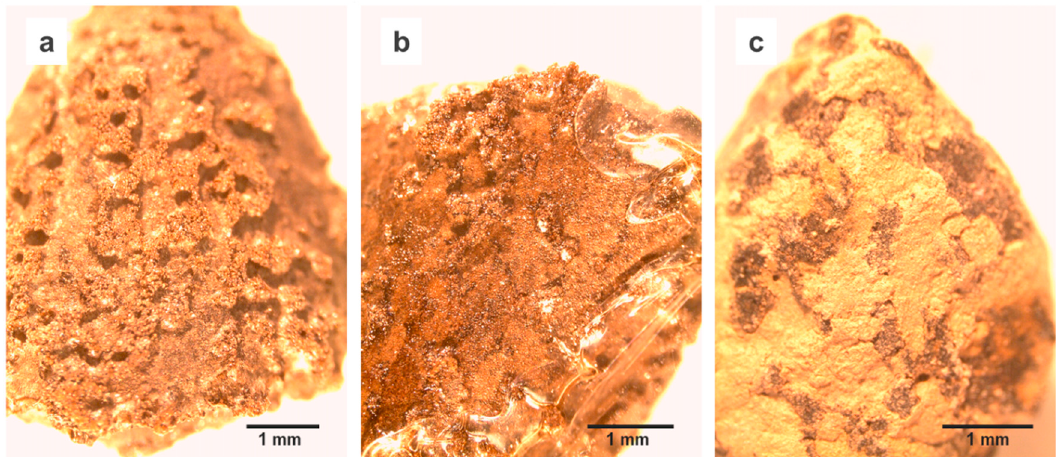
Figure 1. Film formation on seed surface of P. radiata seeds: ( a ) control (sterile water), ( b ) coating based on medium molecular weight chitosan (CM MW ) and ( c ) coating based on low molecular weight chitosan (CL MW ) with halloysite.